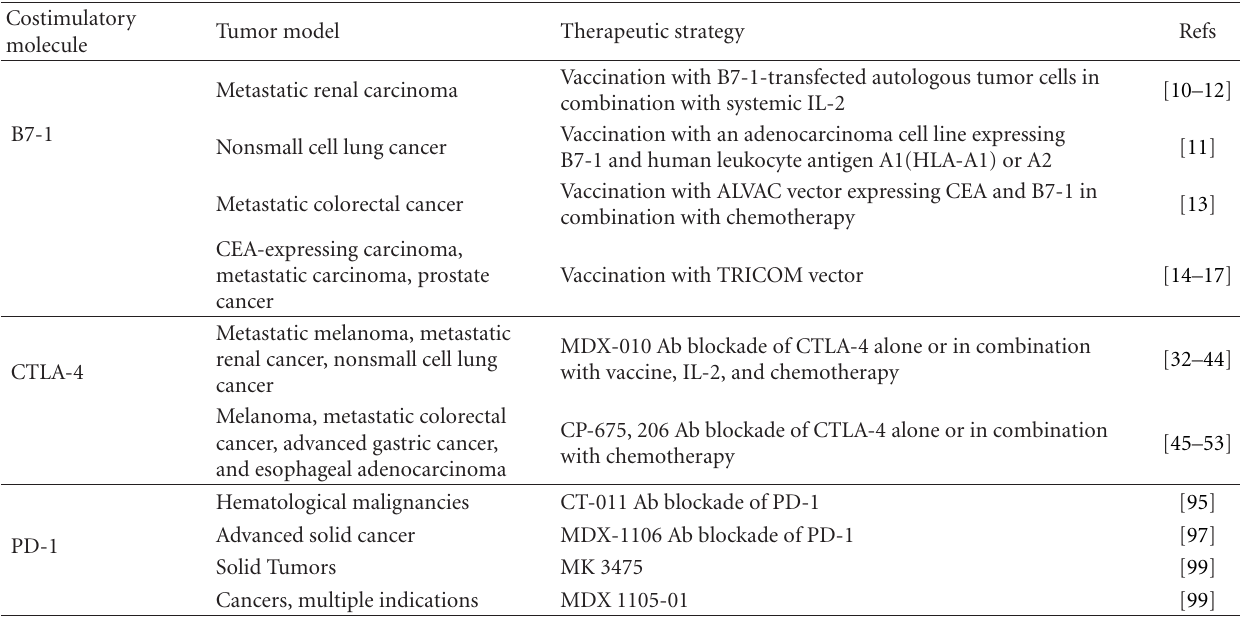
Table 1: Clinical trials of B7:CD28 costimulatory